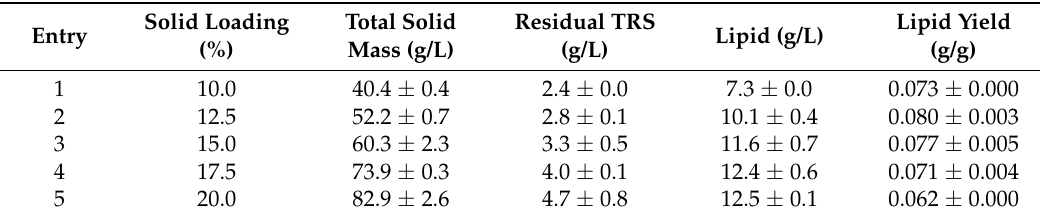
Table 3. The results of lipid production at 30 ◦ C under various solid loadings.